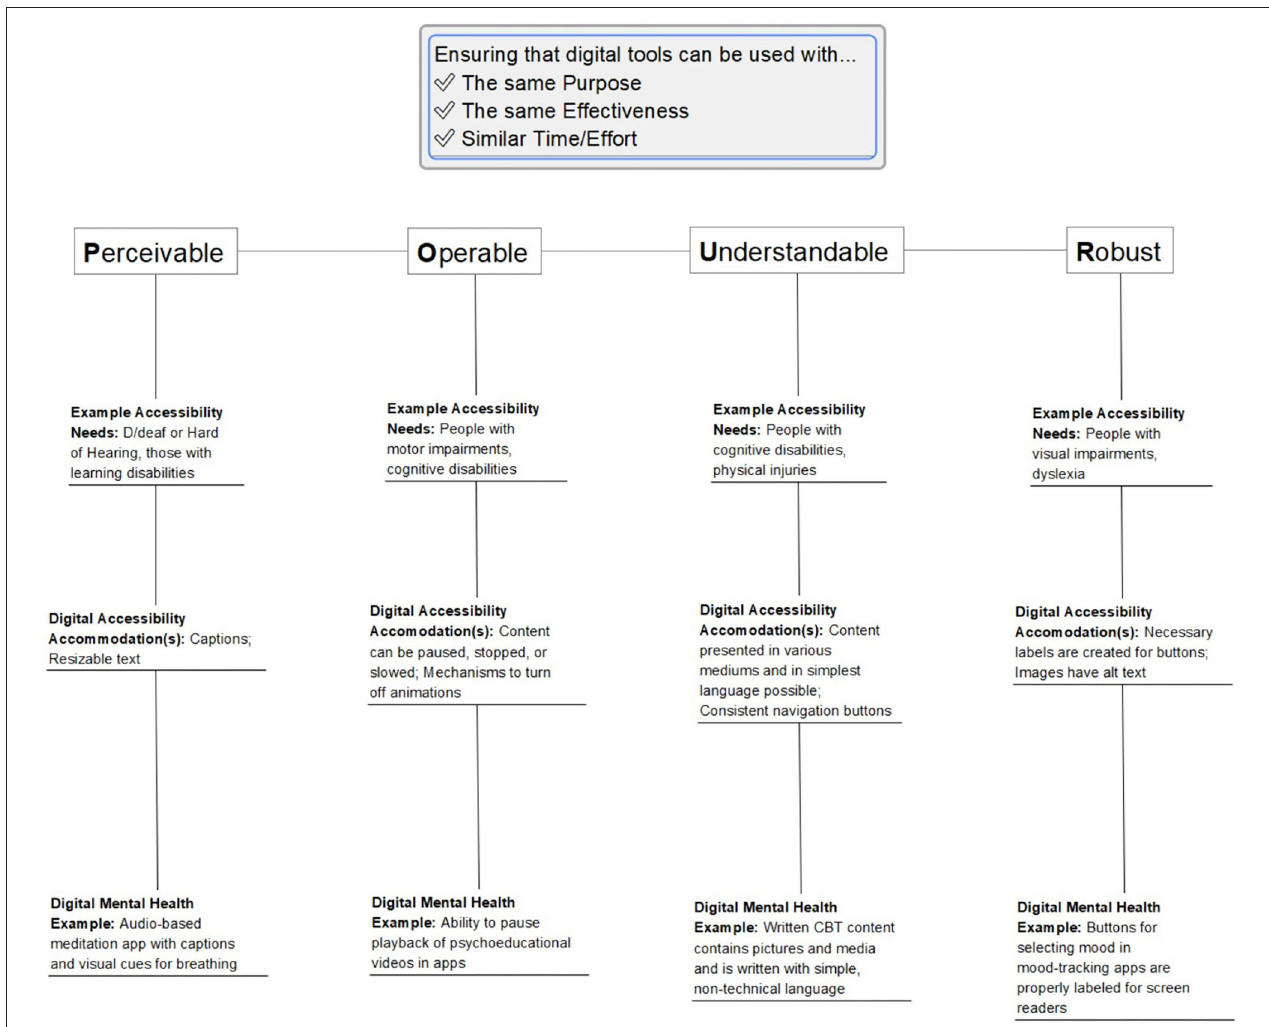
FIGURE 1 | Applying the Web Accessibility Initiative (WAI) POUR guidelines to digital mental